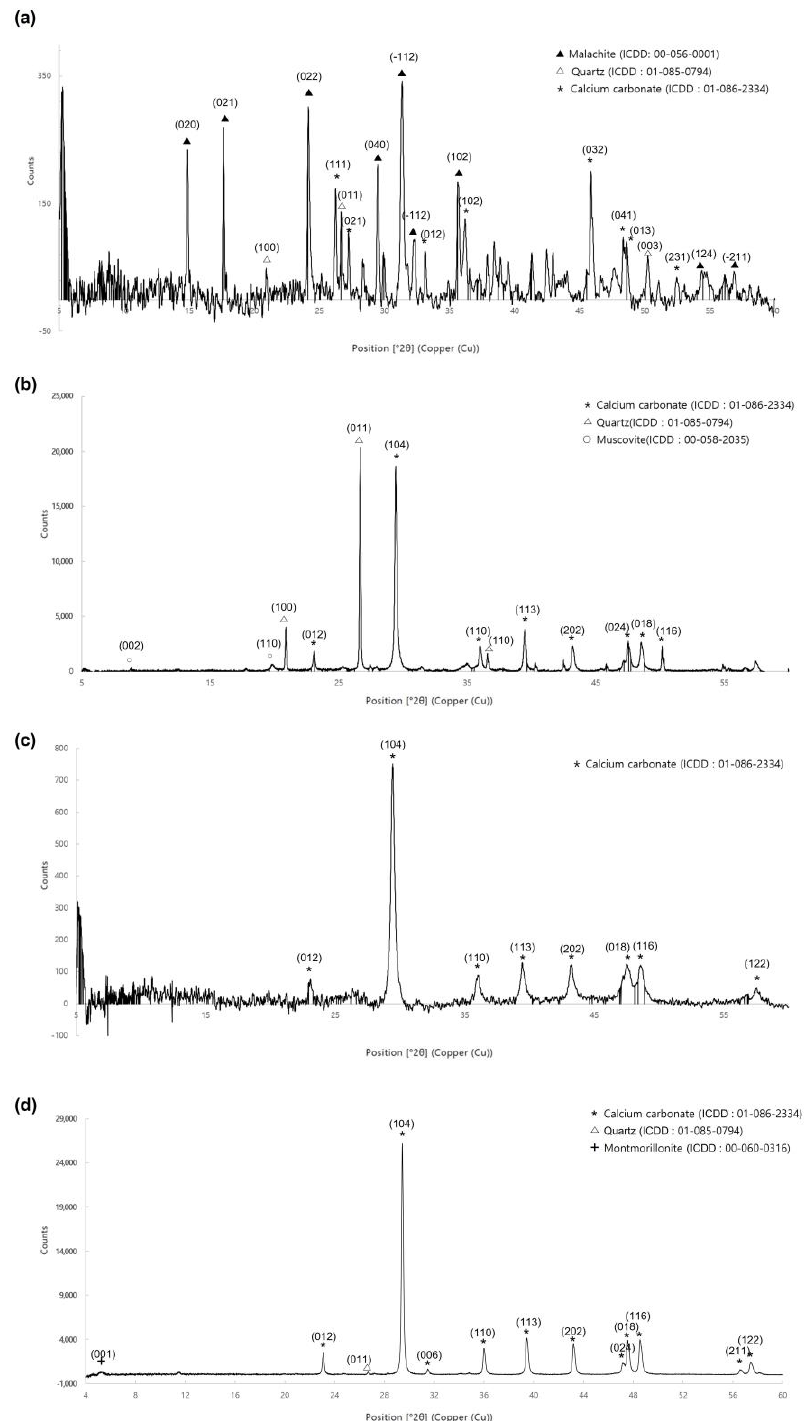
Figure 13. X-ray diffractometer (XRD) spectrum of mural sample. ( a ) Painting layer. ( b ) Earthen layer. ( c ) White particle in earthen layer. ( d ) Lime layer.